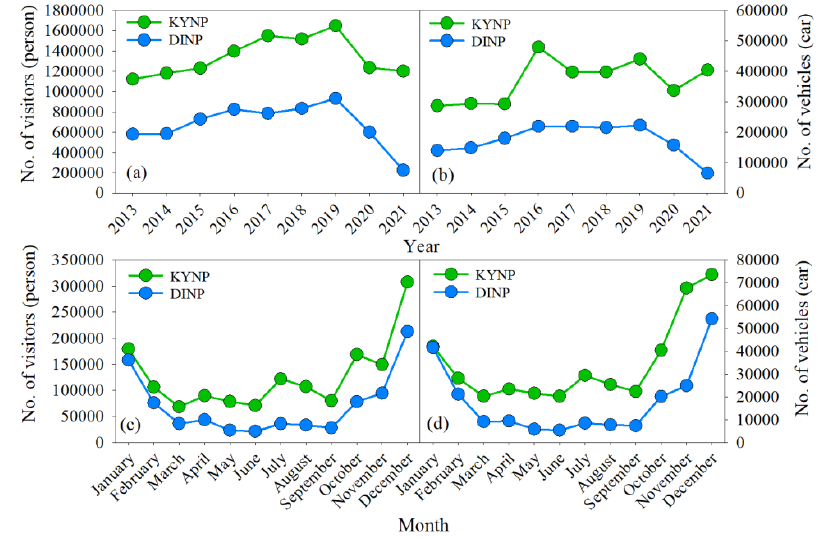
Figure 2. Yearly numbers of visitors ( a ) and vehicles ( b ) from 2013 to 2021 and monthly numbers of visitors ( c ) and vehicles ( d ) averaged from 2016 to 2019 (Source: National Parks of Thailand; Available online: https://portal.dnp.go.th/Content/nationalpark?contentId=22377 (accessed on 14 February 2023)).